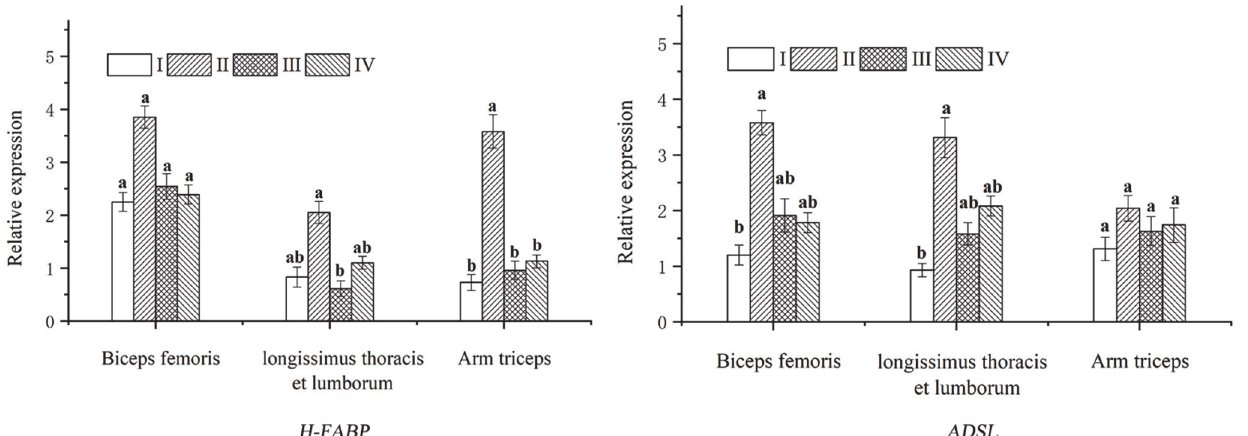
Figure 2. Effect of different processing methods of Morus alba TMR diet on the expression of H- FABP and ADSL genes in the muscle of black goats. Different bars in the graph indicate different experimental groups. Different superscript lowercase letters in the same row (a, b) indicate significant differences ( p < 0.05).